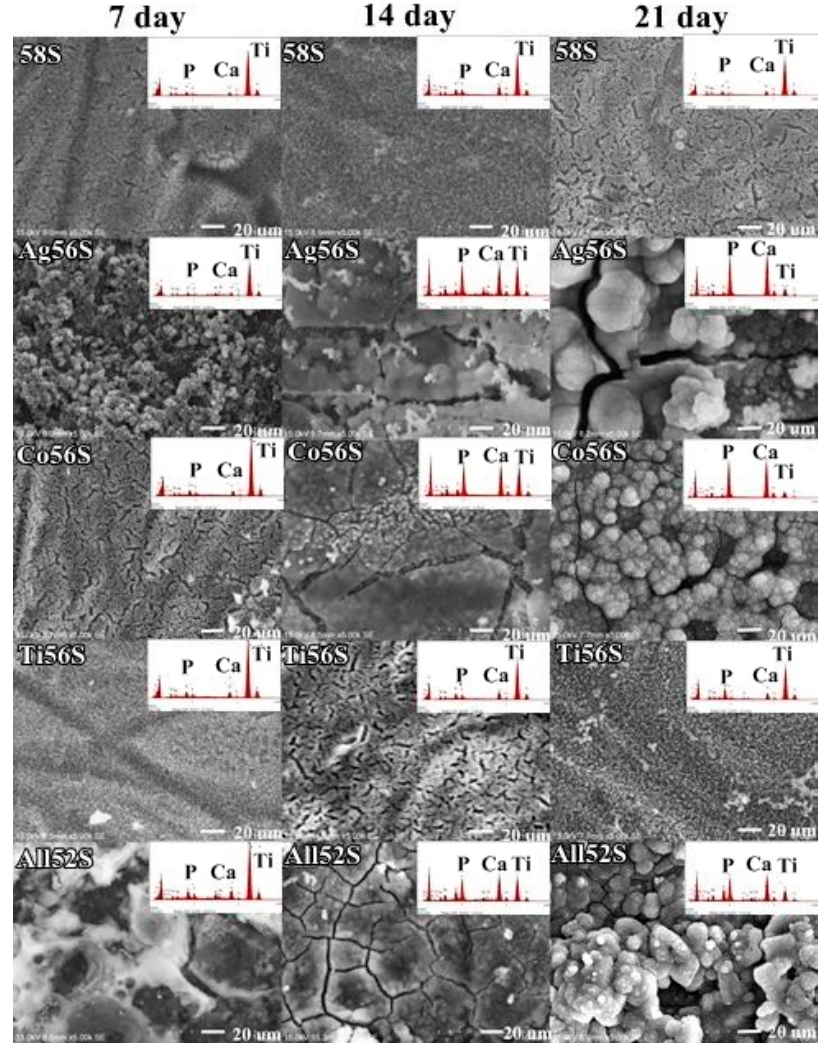
Figure 3. SEM micrographs (5000×) of the bioactive glass coatings immersed in HBSS at 7, 14 and 21 d. Mineral formation with Ca and P can be observed for the Ag56, Co56 and All52S